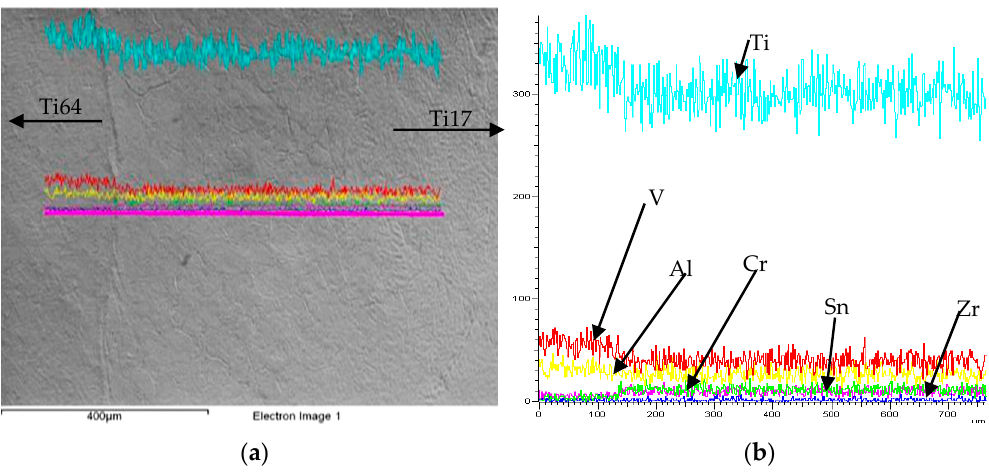
Figure 5. ( a ) SEM micrograph of LFW joints with Ti64 and Ti17 alloys and ( b ) the corresponding SEM-EDS line scans across the interface.